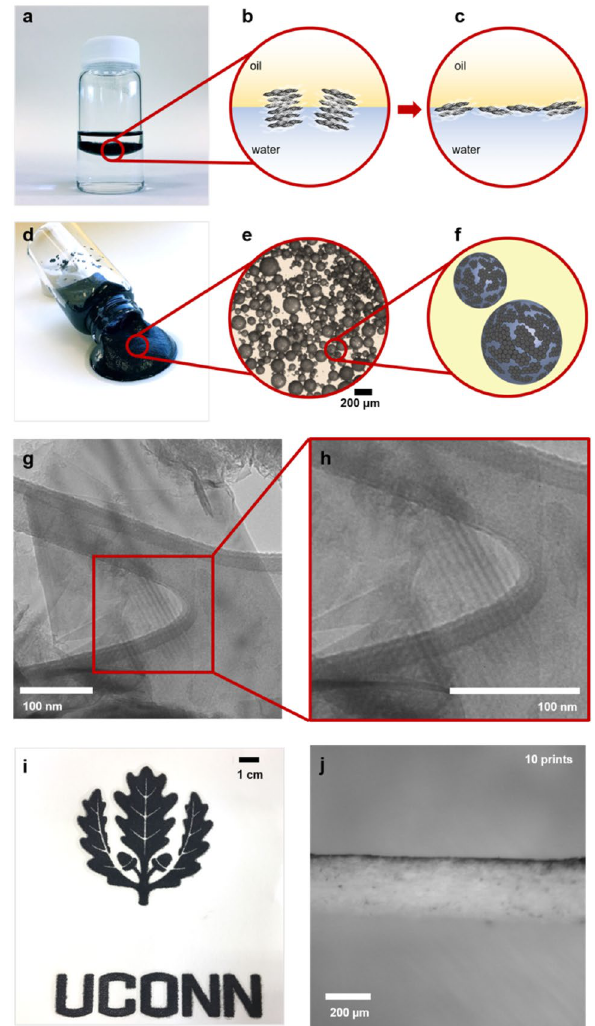
Figure 1. ( a ) Vial containing hexadecane (top), water (bottom), and graphite. Although denser than water, the graphitic material is pinned at the oil/water interface; ( b ) illustration of graphite initially at the oil/water interface; ( c ) overlapping graphene sheets at the solvent interface after the spontaneous spreading (exfoliation) of the graphite; ( d ) conductive ink consisting of graphene stabilized water-in-oil emulsion; ( e ) optical microscopy image of the ink showing graphene stabilized water droplets; ( f ) illustration of water-in-oil emulsion with graphene stabilizing the interface; ( g ) TEM image of graphene prepared by interfacial trapping showing overlapped exfoliated sheets; ( h ) magnified image showing the moiré pattern on graphene formed by re-stacked exfoliated graphene sheets; ( i ) UCONN (University of Connecticut) logo printed on paper using graphene emulsion ink; ( j ) A cross-section of graphene emulsion ink printed on